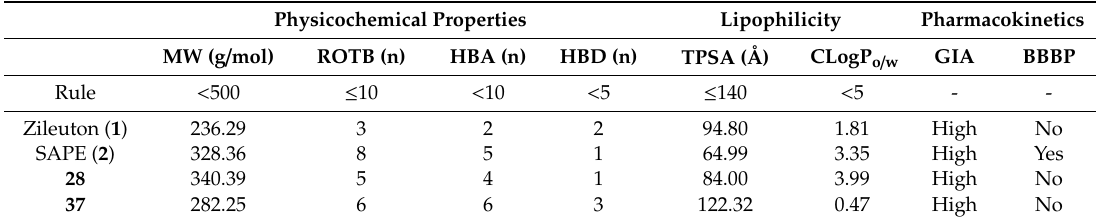
Table 3. Absorption, distribution, metabolism, and excretion (ADME) profile of molecules of interest.